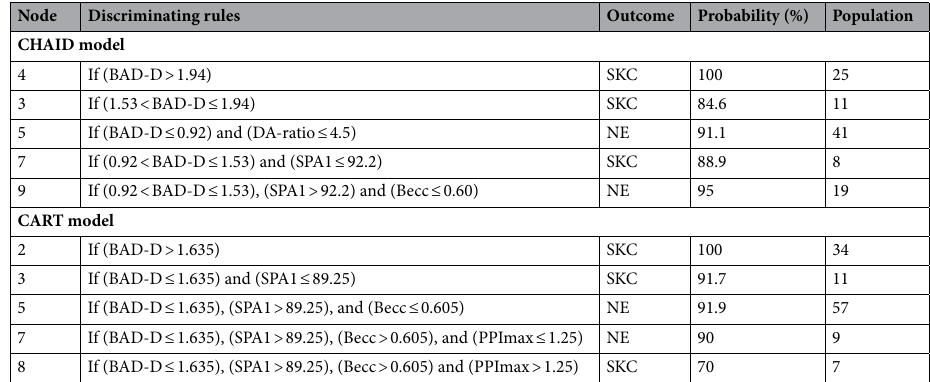
Table 2. Predictions of CHAID and CART for the outcome to discriminate NE and SKC in training database. BAD-D Belin/Ambrósio Enhanced Ectasia Display Index, DA-ratio deformation amplitude ratio, SPA1 stiffness parameter at first applanation, Becc back eccentricity, PPImax maximum of pachymetric progression